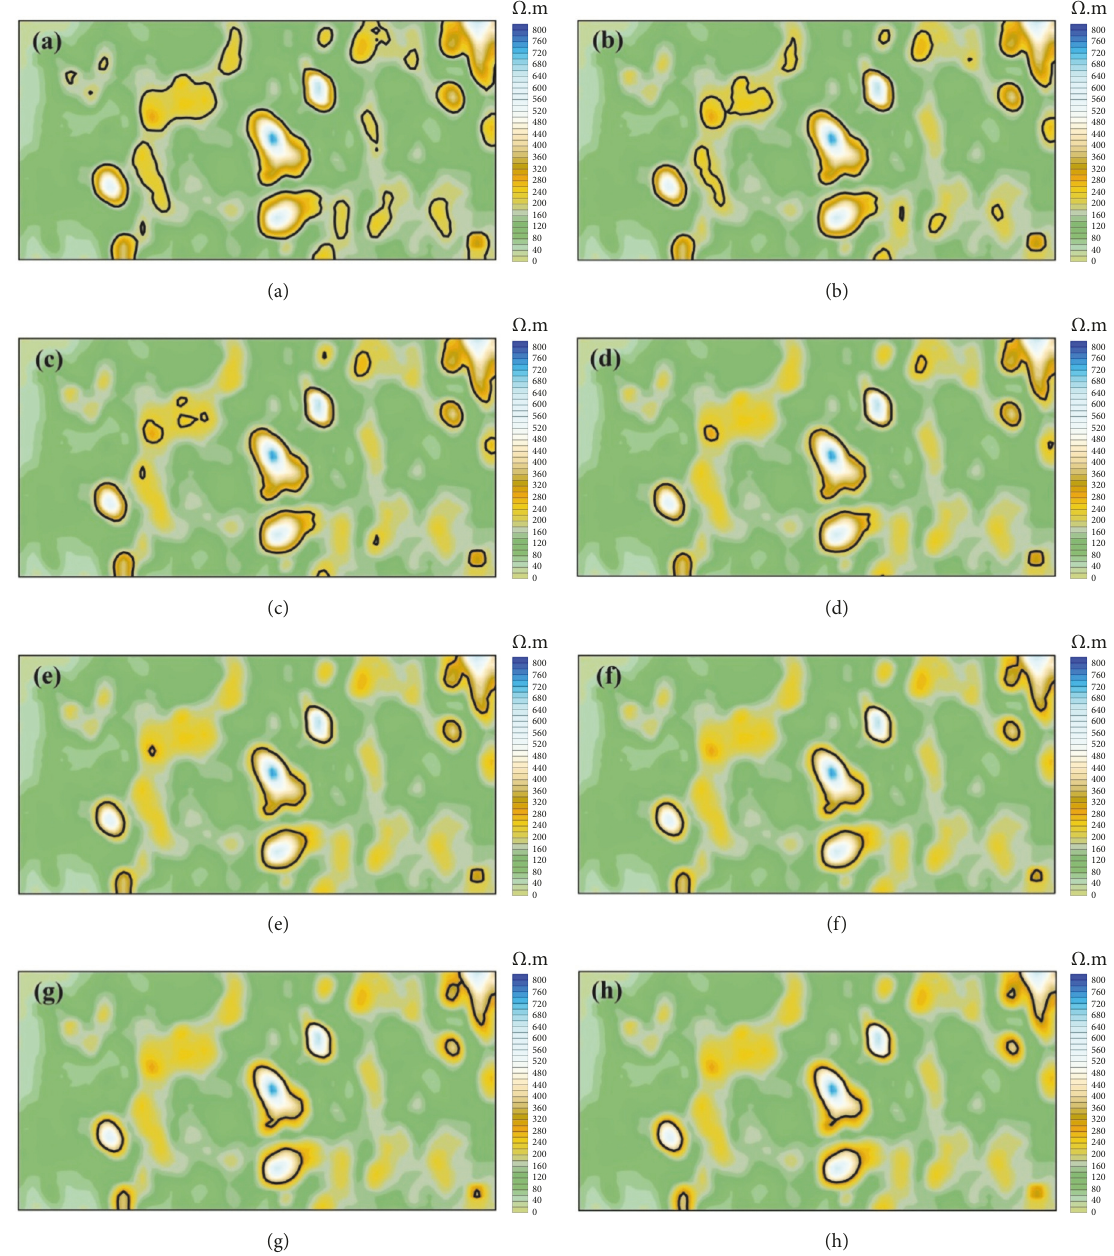
Figure 3: The visual spatial patterns of the disturbances extracted from 200 Ω .m to 340 Ω .m using a cutoff frequency of 20 Ω .m. The cutoff frequencies (cid:2) a . r used are, respectively, (a) (cid:2) a . r = 200 Ω .m, (b) (cid:2) a . r = 220 Ω .m, (c) (cid:2) a . r = 240 Ω .m, (d) (cid:2) a . r = 260 Ω .m, (e) (cid:2) a . r = 280 Ω .m, (f) (cid:2) a . r = 300 Ω .m, (g) (cid:2) a . r = 320 Ω .m, and (h) (cid:2) a . r = 340 Ω